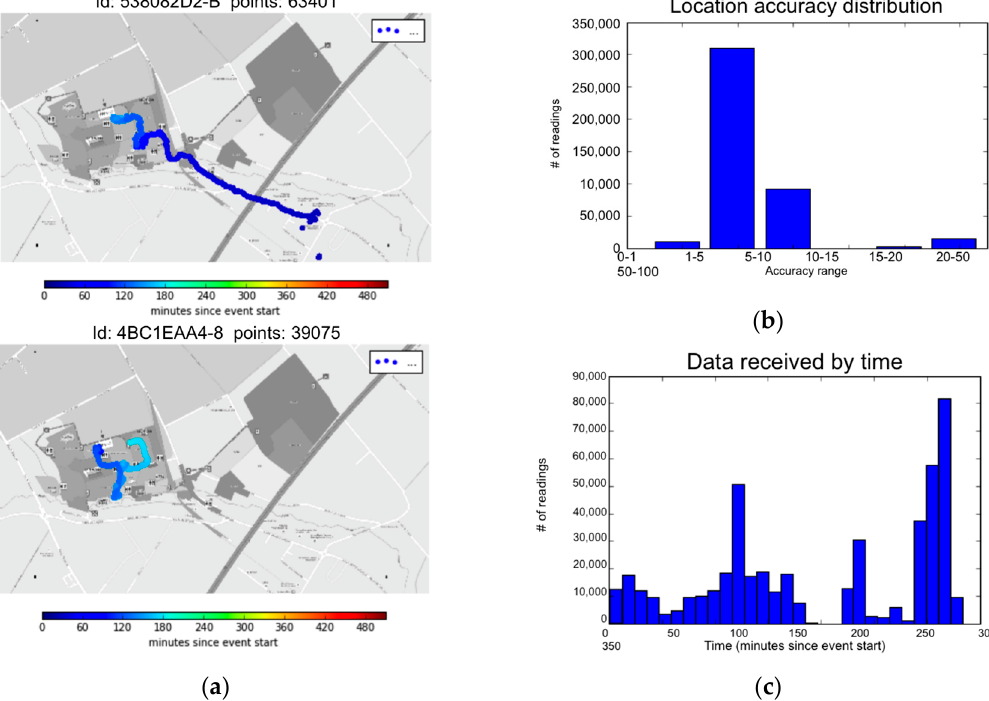
Figure 9. ( a ) Two users’ location points during the one-hour collect time. ( b ) The accuracy distribution and ( c ) the time distribution of data collected during the